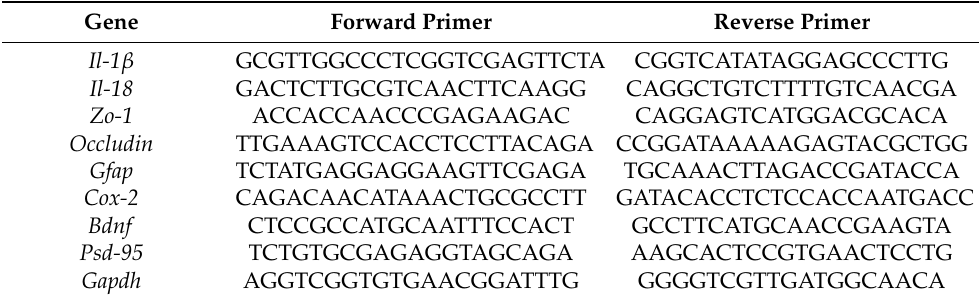
Table 1. Primer sequences of the genes used for the